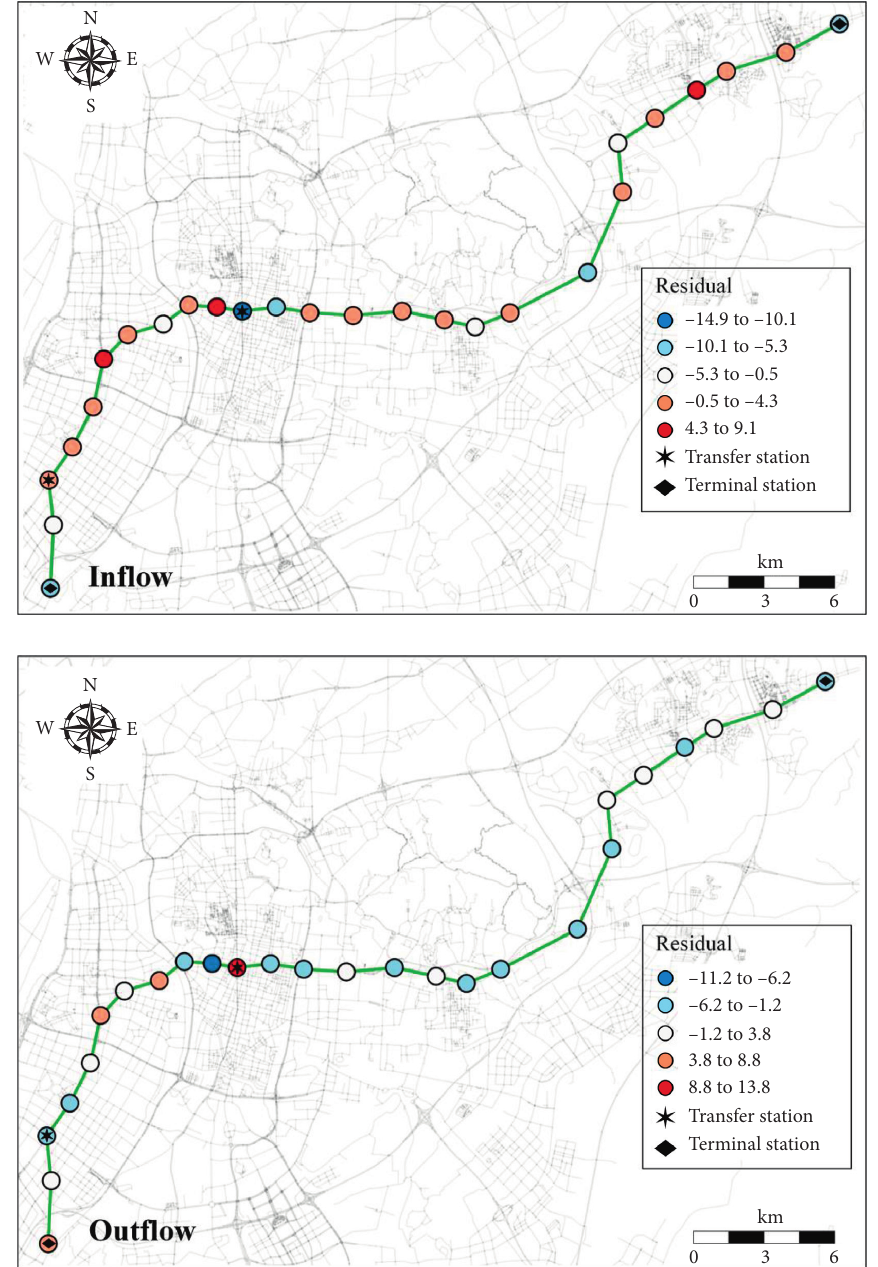
Figure 7: The spatial distribution of prediction errors for each